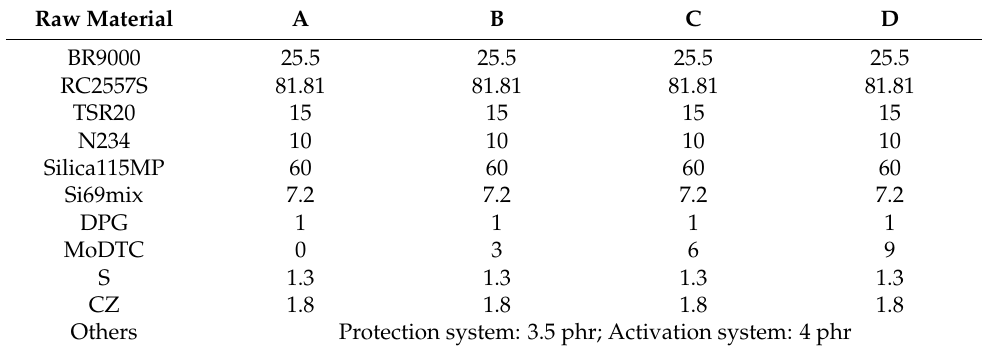
Table 1. The sample formula (unit: